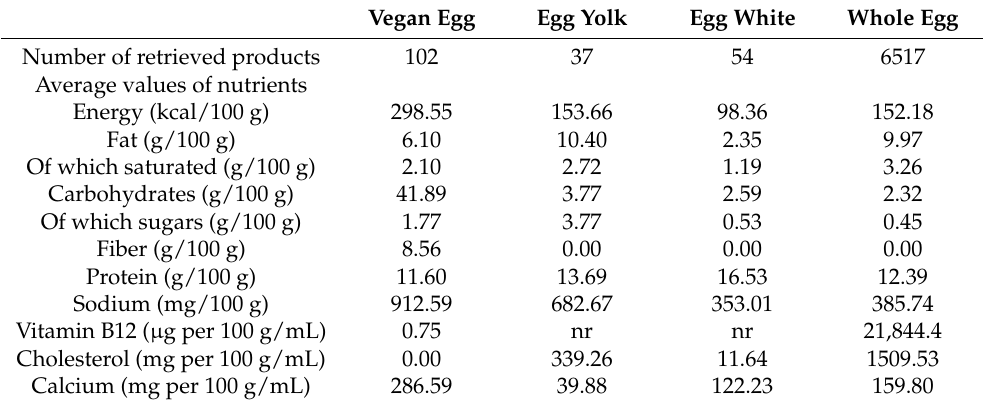
Table 3. Nutritional composition of eggs (per 100 g) and their alternatives in the global market 1 . Vegan Egg Egg Yolk Egg White Whole